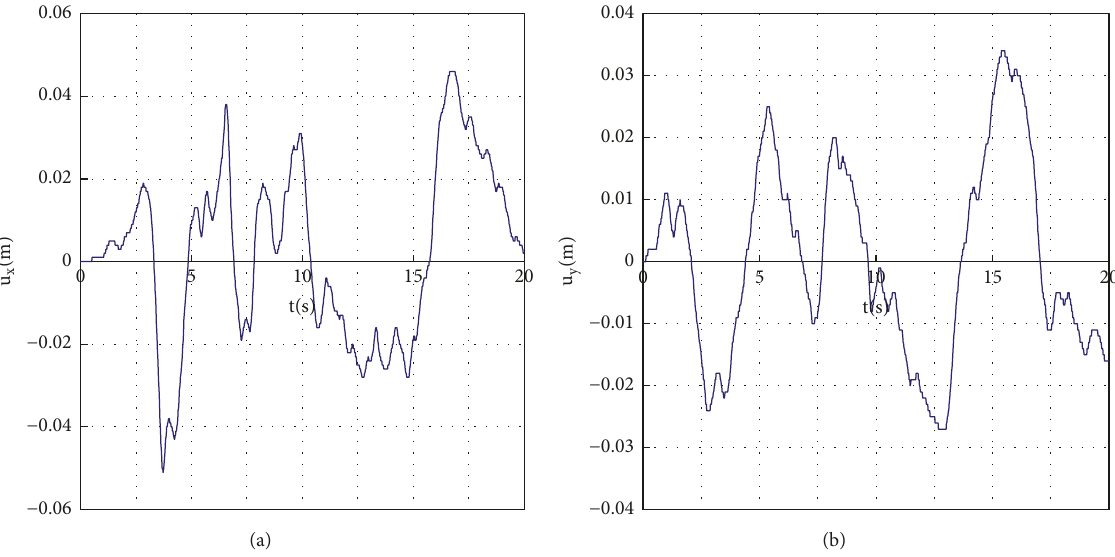
Figure 10: Displacement time history of Taft earthquake: (a) horizontal and (b)